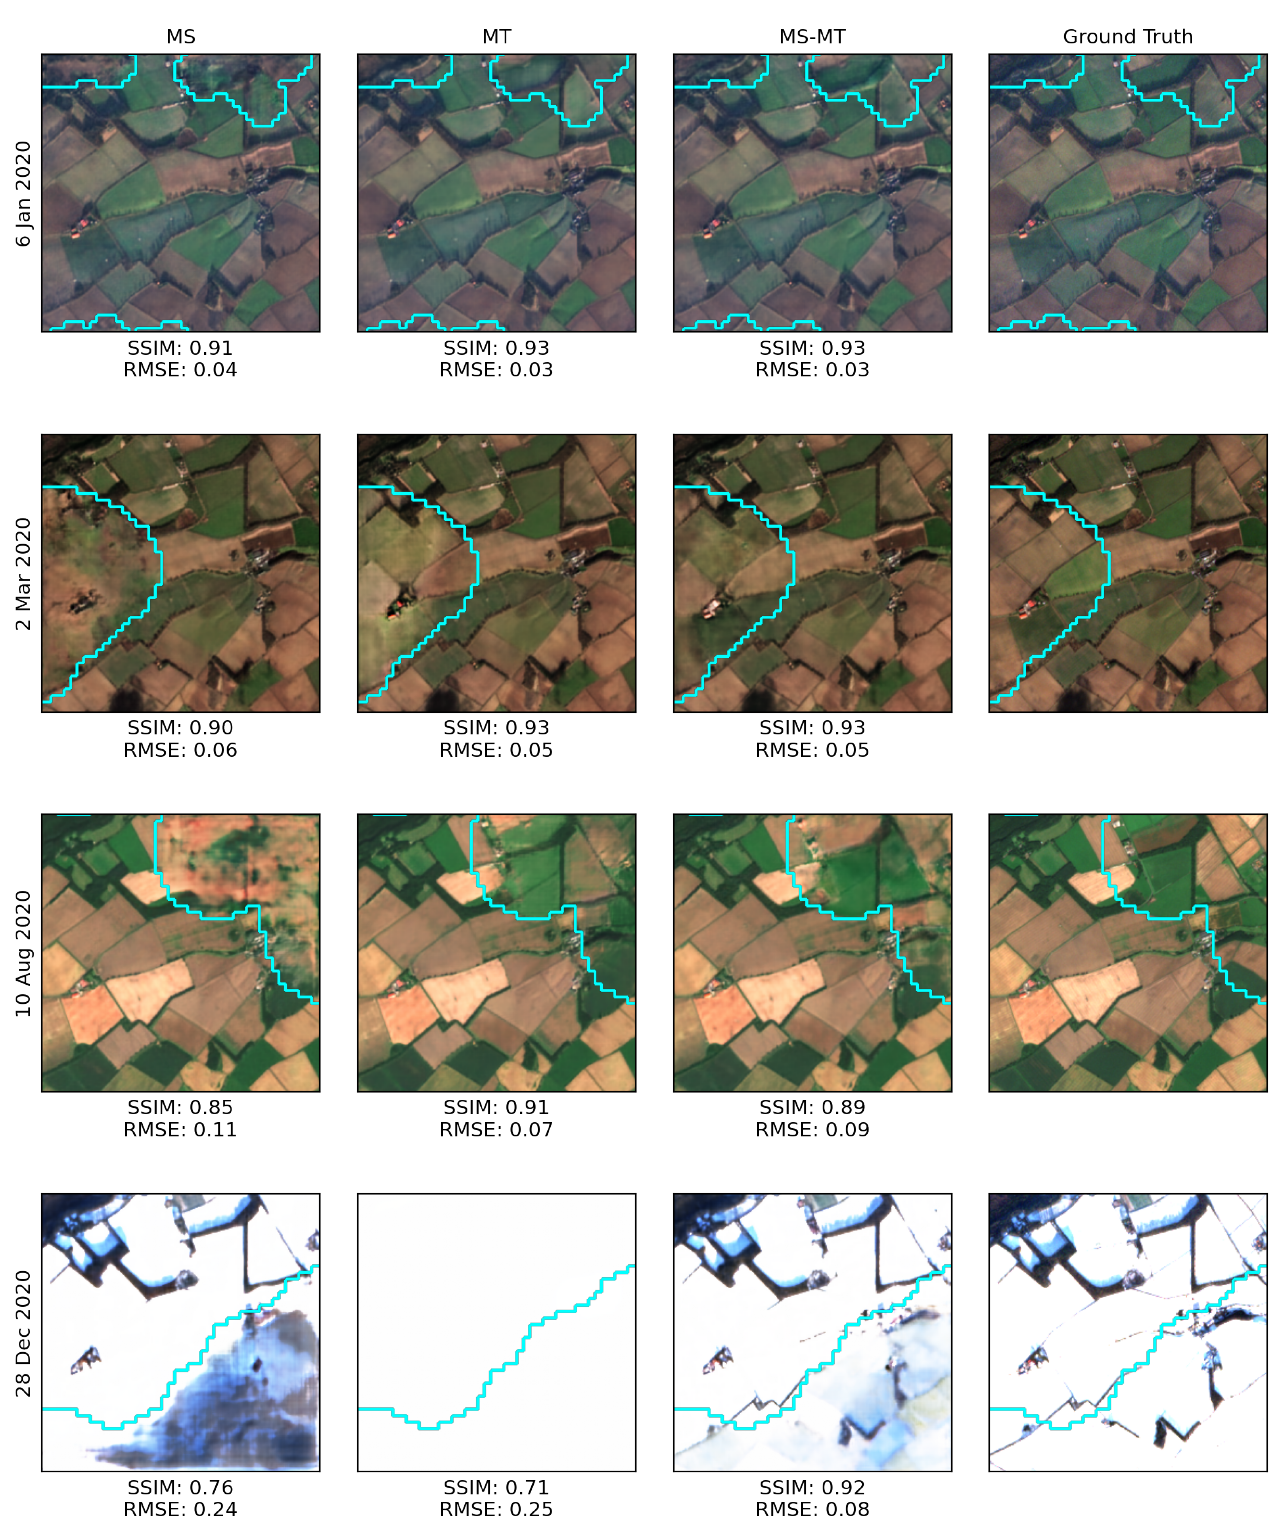
Figure 7. A selection of reconstructed samples across the full year in the Scotland region. This demonstrates the seasonal adaptability of the proposed methods. The cyan line delineates the cloud-affected from the cloud-free regions in the